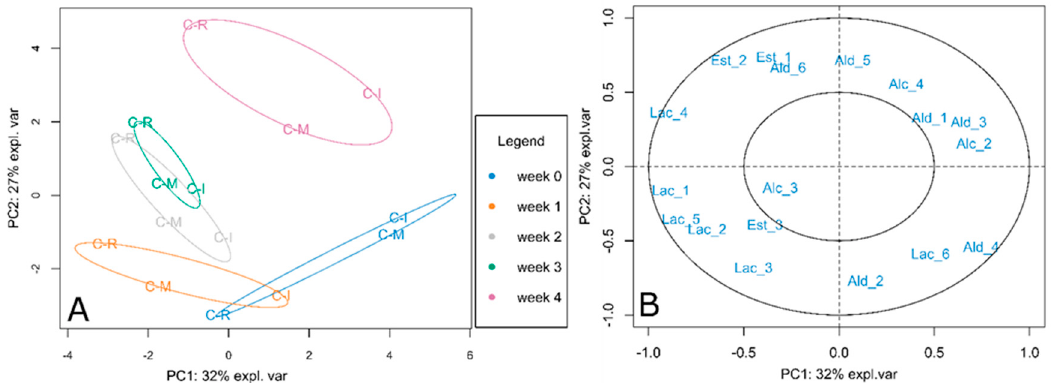
Figure 4. ( A ) Two-dimensional principal component analysis (PCA), elaborated using the VOCs quantified by the GC-MS at day 6 of simulated shelf-life for the three maturity classes (C-I: immature; C-M: mature; C-R: ripen. The ellipse confidence level is set at 0.5 (50% region). ( B ) Variable plot projecting the variables (VOCs) identified at day 6 of simulated shelf-life. VOCs ID is reported in Table 1. Two circumferences of radius 1 and 0.5 are plotted to report the correlation structure of the variables.